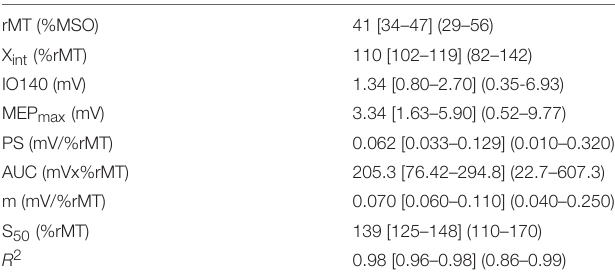
TABLE 2 | Electrophysiological parameters in the dominant hemisphere of healthy